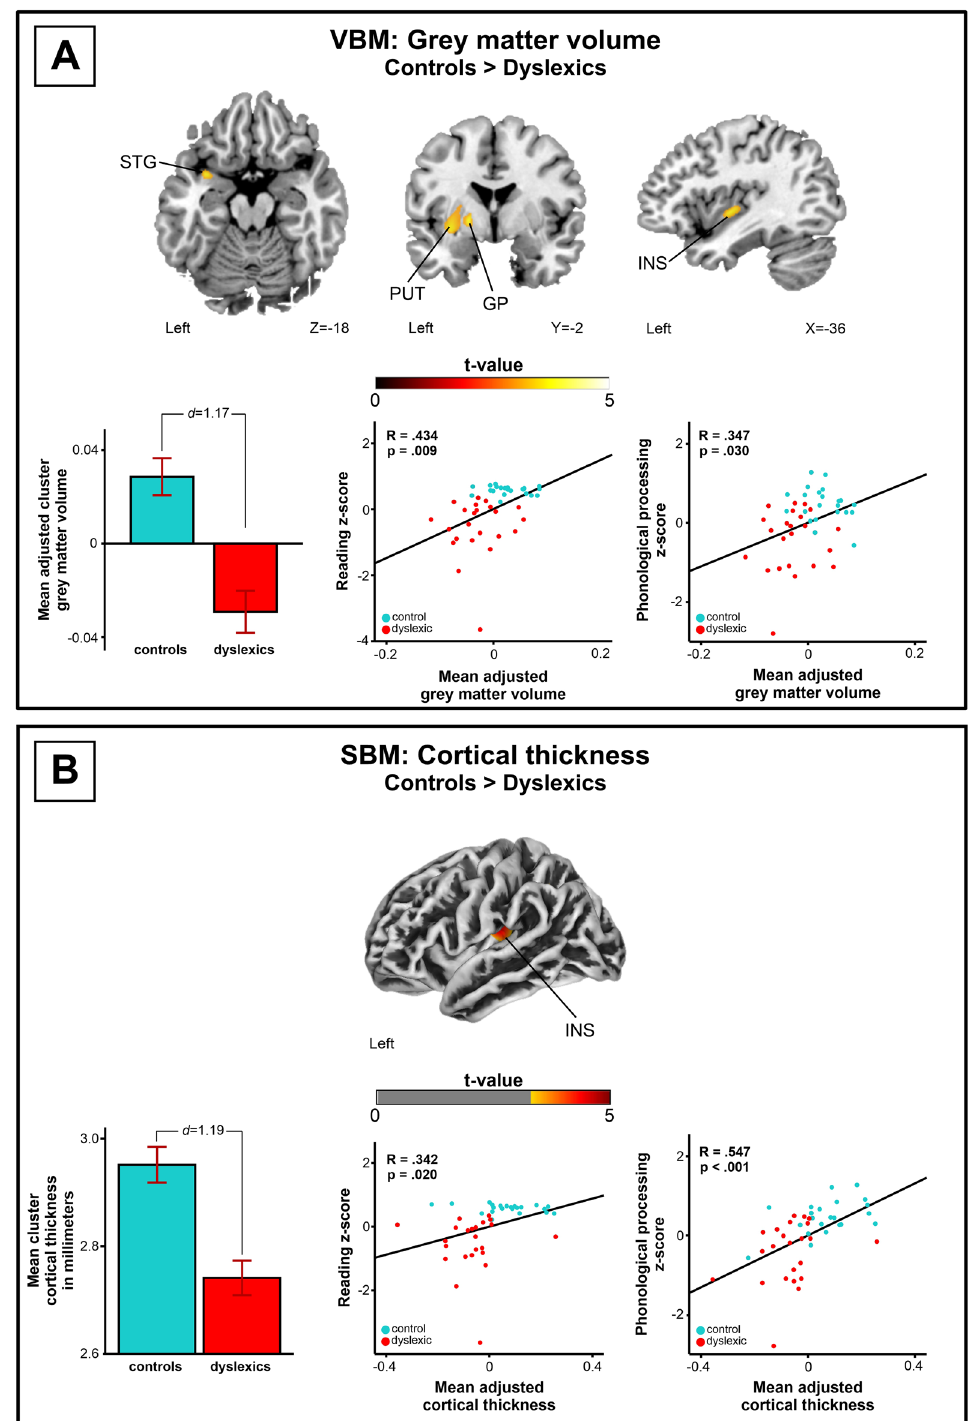
Figure 1. VBM and SBM group differences (see also Table 3). ( A ) Grey matter volume anomalies in dyslexia (Controls > Dyslexics). ( B ) Cortical thickness anomalies in dyslexia (Controls > Dyslexics). N = 45. Statistical maps are thresholded at a cluster-level FWE-corrected p < 0.05 threshold. Mean adjusted cluster grey matter volume and mean adjusted cluster cortical thickness correlations to reading-related skills are shown with scatter plots. Bar plots for mean adjusted grey matter volume and mean cortical thickness in significant clusters (Table 3) are shown: bar = mean, error-bar = standard error of mean, d Cohen’s d, GP globus pallidus, INS insula, PUT putamen, STG superior temporal